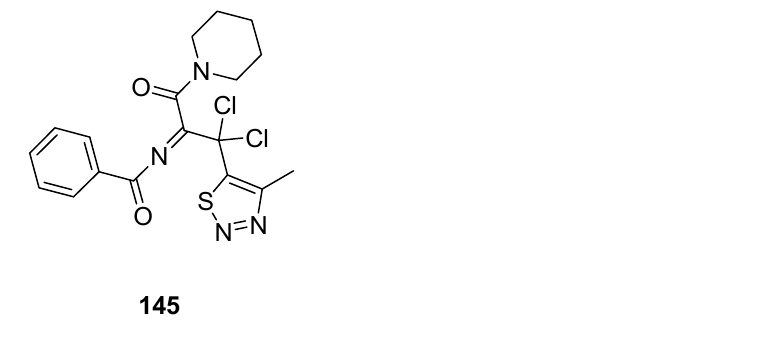
Figure 29. Piperidine based 1,2,3-Thiadiazole 145 with moderate antifungal activity. Another group reported the fungicidal properties of 1,2,3-thiadiazole derivatives against Alternaria solani (AS), Botrytis cinerea (BC), Cercospora arachidicola (CA), Cercospora beticola (CB), Colletotrichum lagenarium (CL), Fusarium oxysporum (FO), Gibberella zeae (GZ), Macrophoma kuwatsukai (MK), Phytophthora infestans(Mont) de Bary (PI), Physalospora piricola (PP), Pellicularia sasakii (Shirai) (PS), Puccinia triticina Eriks (PT) and Rhizoctonia solani Kuhn (RS) [156]. The most active occurred to be structure 146 (Figure 30) showed potent fungicidal inhibitory activity 84.8, 83.9, 83.3, 78.9, 75.0, 71.4, 70.7, 66.7, 64.7 and 63.6% against PS, PP, RS, PT, FO, CB, PI, AS, CL and CA, respectively. On the other hand, the propyl containing fused 1,2,4-triazolo[1,3,4]thiadiazole 147 (Figure 30) exhibited the best fungicidal inhibition activity 93.0% for FO, 84.9% for BC, 77.8% for PS, 75.8% for PI, 75.0% for GZ, 62.1% for CA, 50.0% for CL, 40.5% for PP, 34.4% for AS and 33.3% for CB. The results of the antifungal study showed that fused 1,2,4-triazolo[1,3,4]thiadiazole led to the development of wide-spectrum antifungal agents [156].